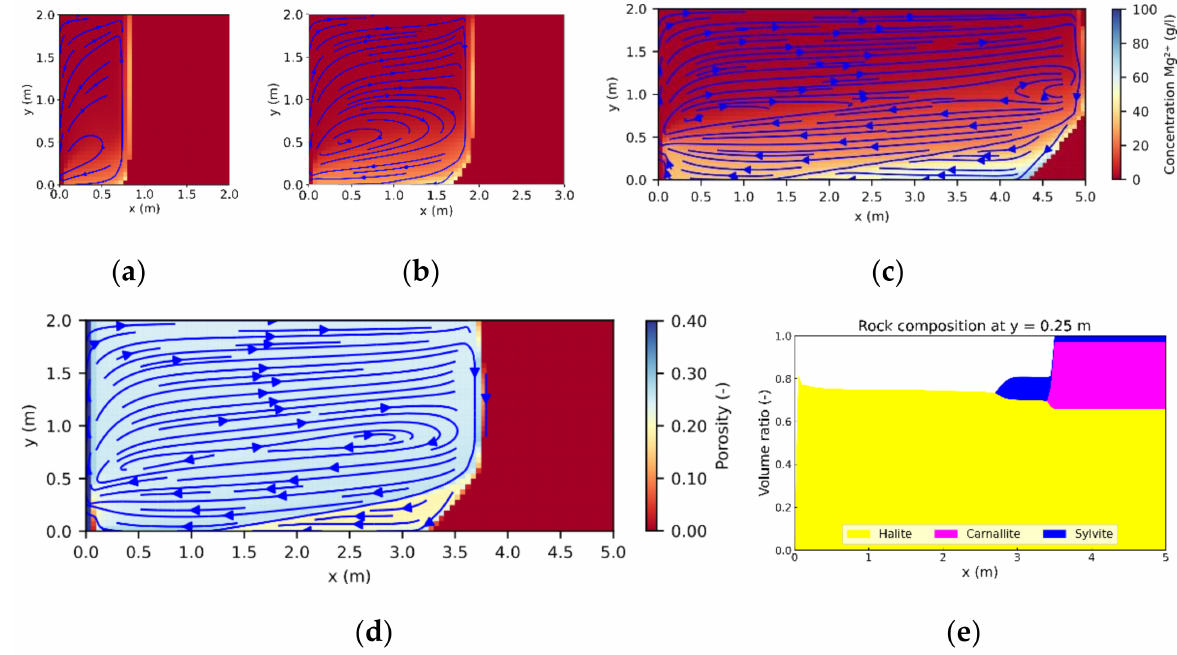
Figure 9. Convection cell of a system shifted from a reaction- to a transport-dominated one: Mg 2+ concentration distribution after simulation times of ( a ) 2 years, ( b ) 5 years and ( c ) 13.4 years; ( d ) porosity distribution and ( e ) mineralogical composition after 10 years for a homogeneous potash seam and k max = 5 × 10 − 6